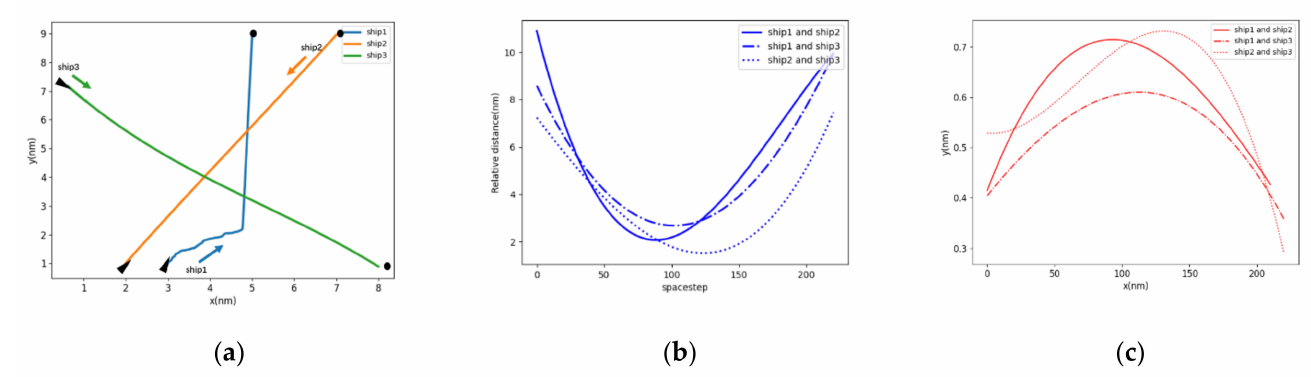
Figure 13. The result of three-ship encounter without measures. ( a ) trajectories; ( b ) relative distance; ( c ) CRI.